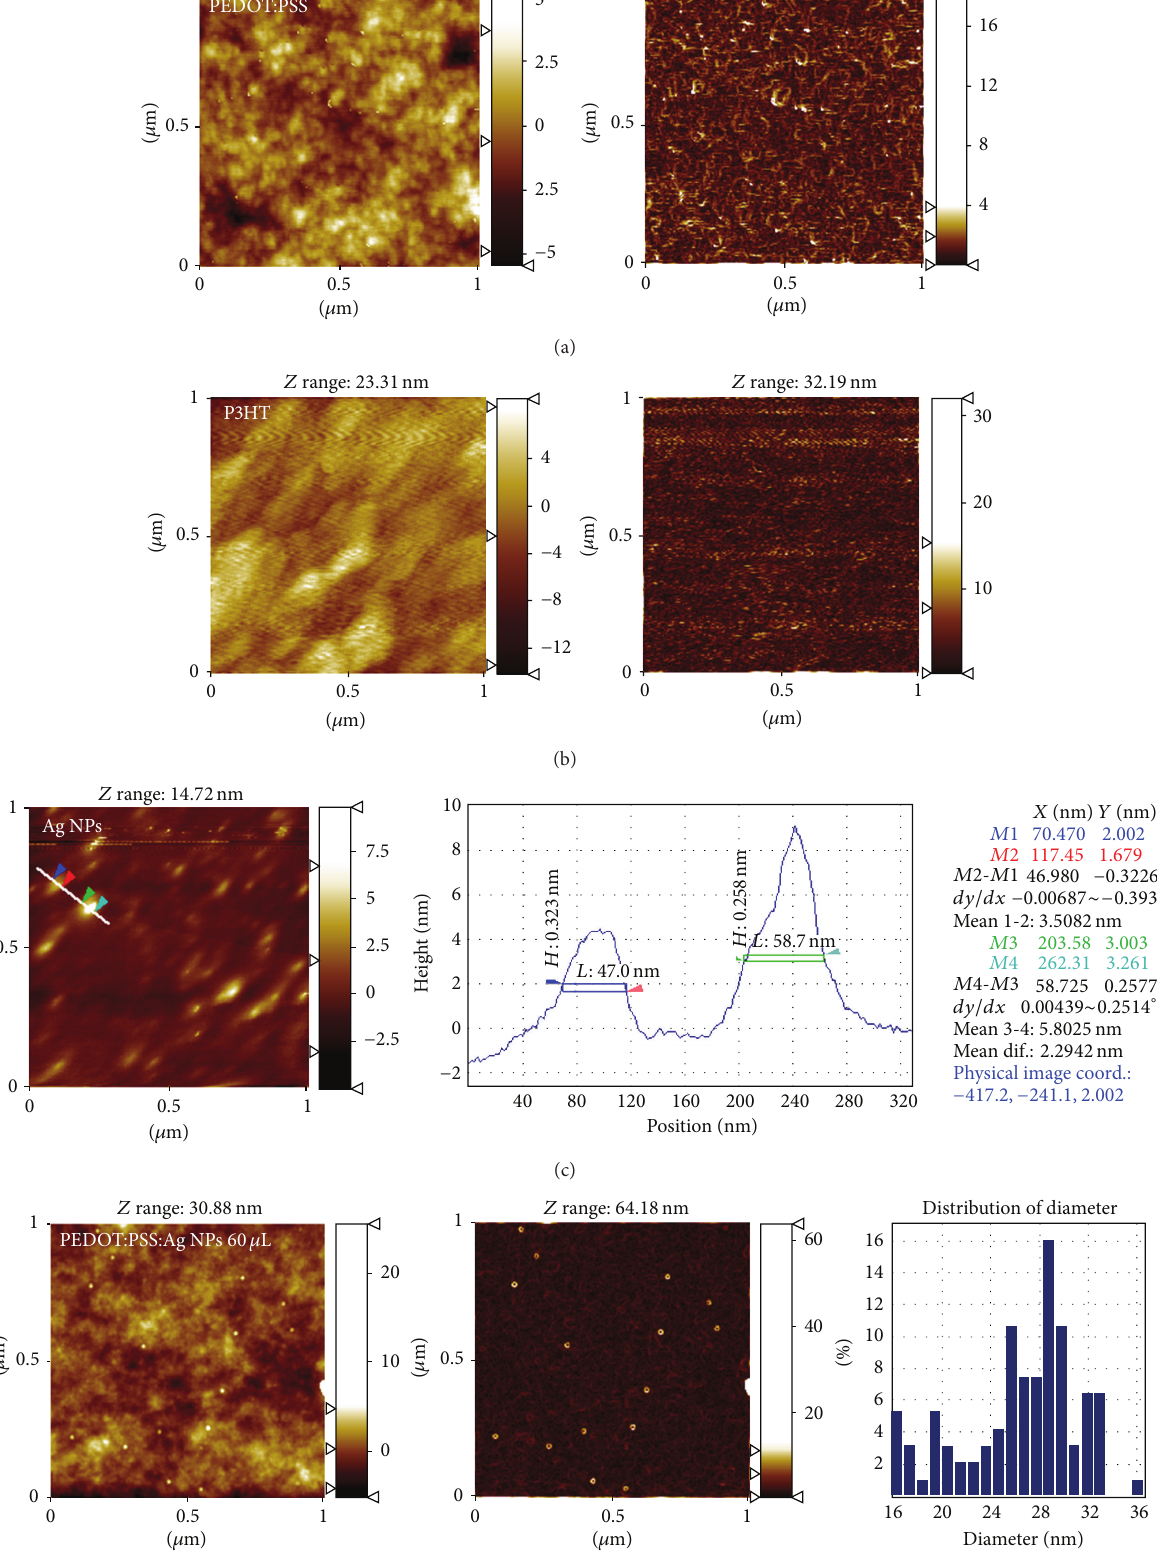
Physical image coord.: −417.2, −241.1,